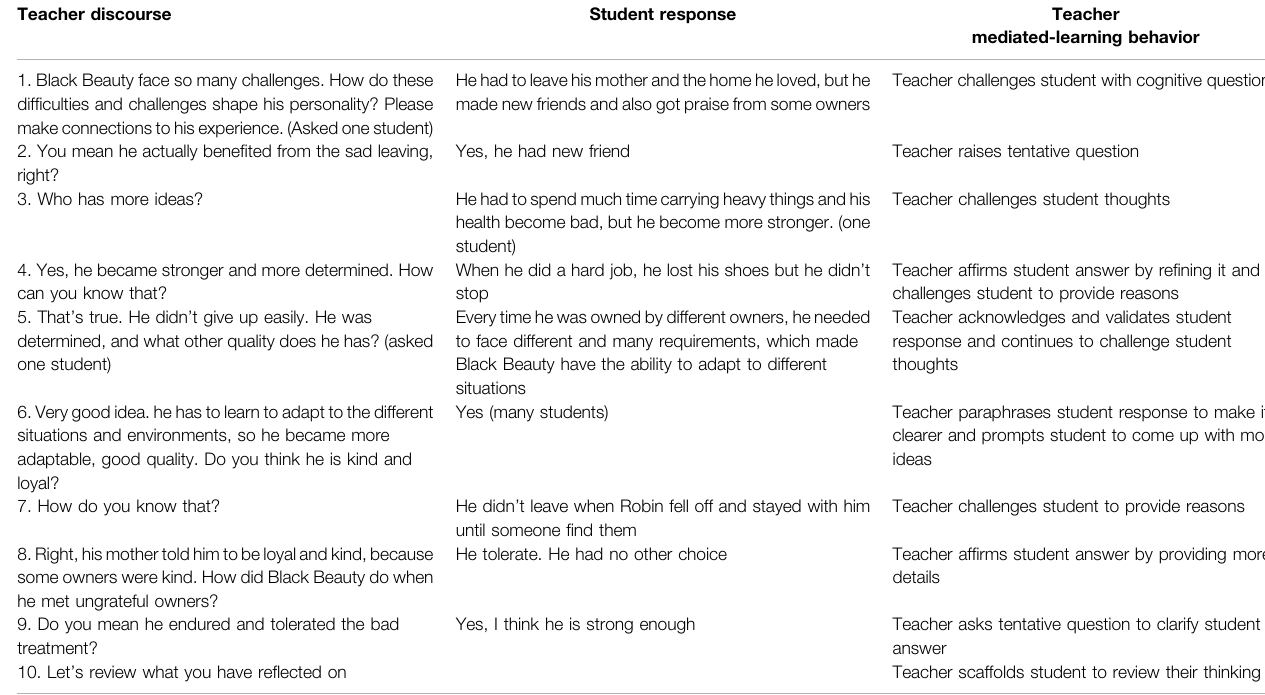
TABLE 6 | Analysis of